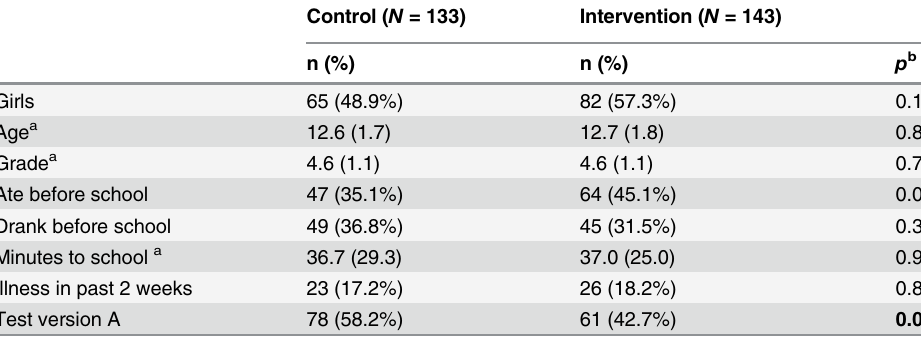
Table 2. Descriptive statistics of sample population by study arm.